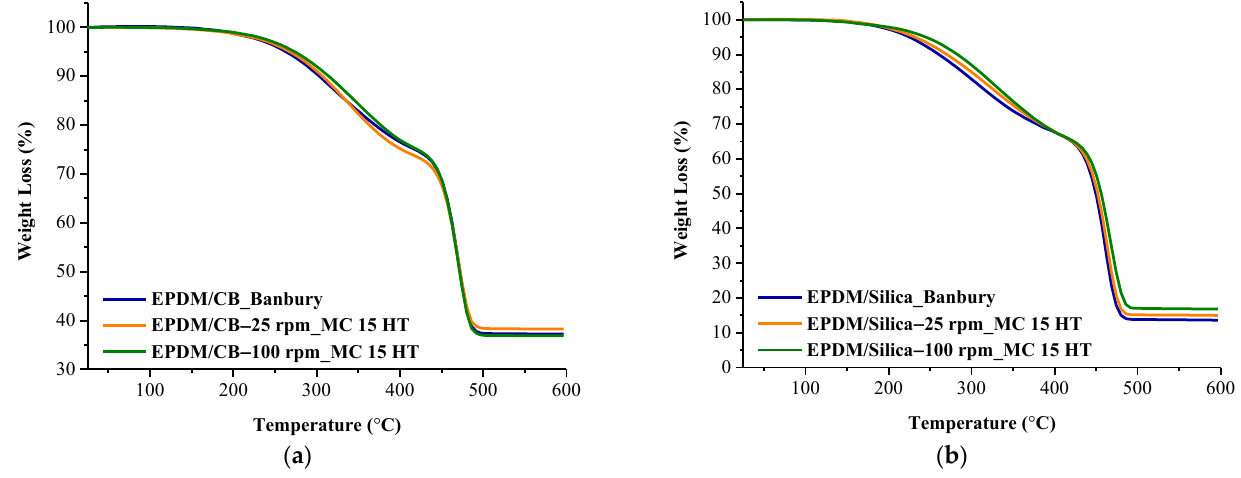
Figure 14. TGA curves of ( a ) EPDM/CB ( b ) EPDM/Silica composites prepared in Banbury and MC 15 HT. Table 5. TGA results of the composites.